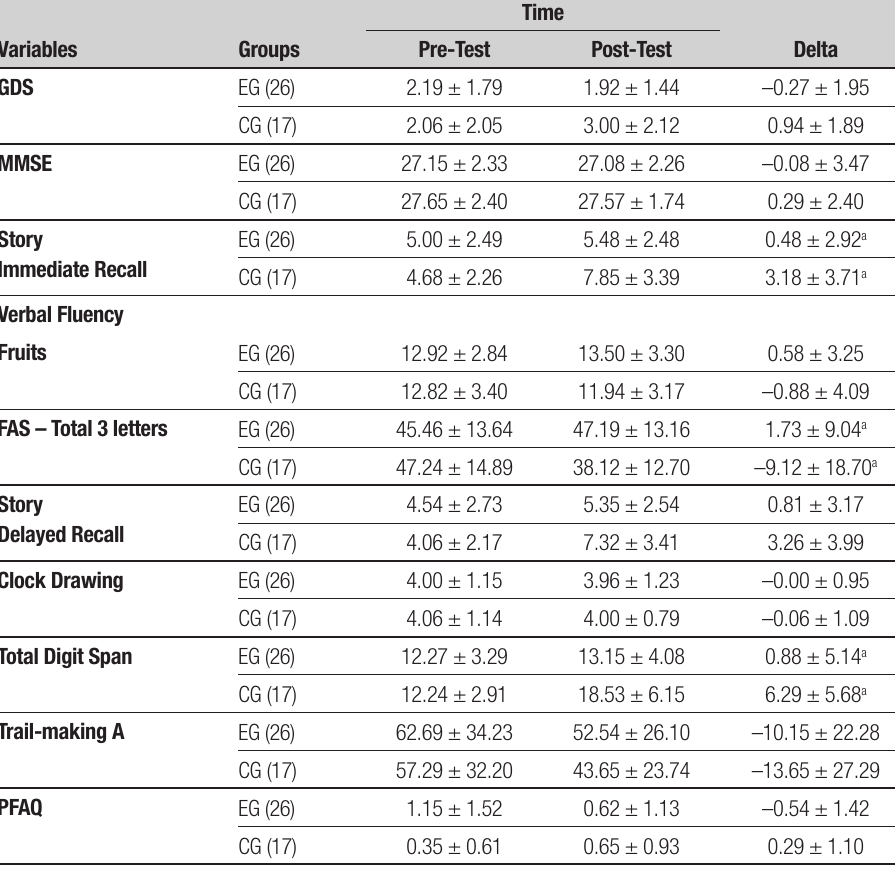
Table 3. Deltas (post-test scores minus pre-test scores) for performance of